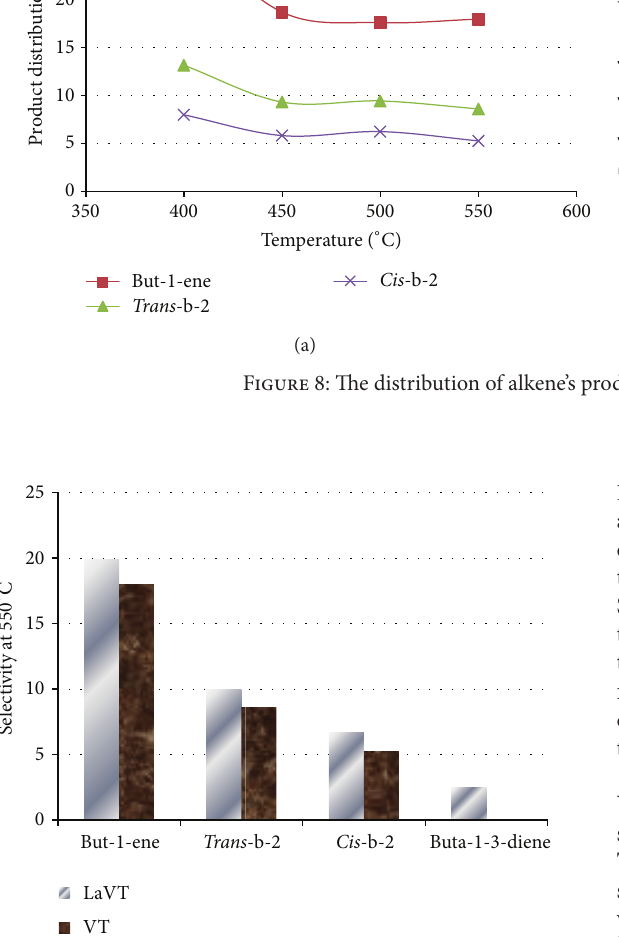
Figure 9: Product selectivity over VT and LaVT catalysts at 550 ∘